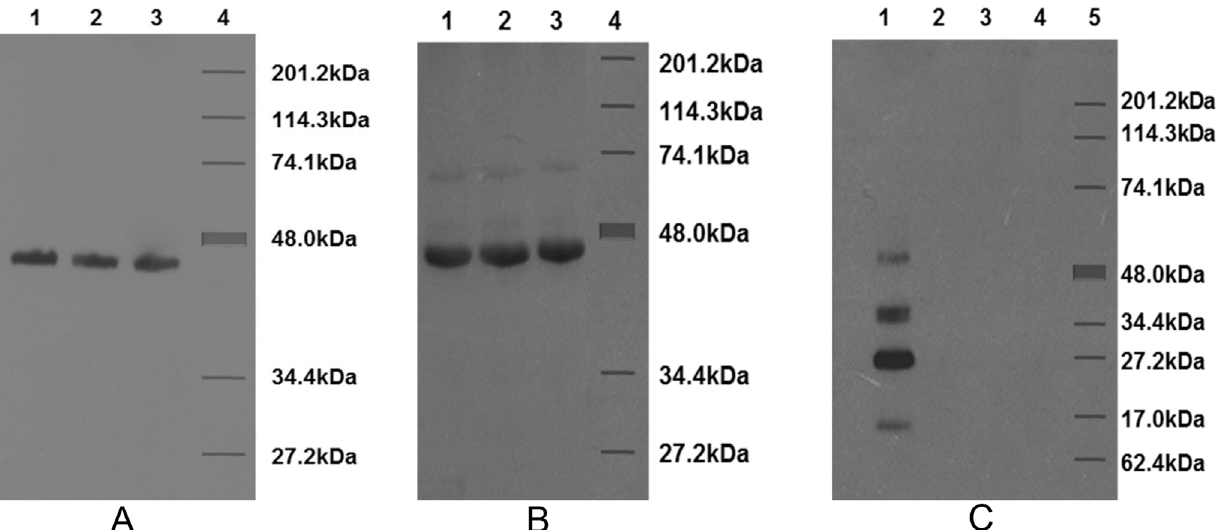
Fig 1. Western blots of enriched MOMPs from C . jejuni strains reacted with rabbit antiserum to the MOMP from C . jejuni strain 111 (A), with rabbit antibody to CT (Sigma) (B), and with rabbit antiserum to dmLT (C). SDS-12% PAGE-separated MOMPs were transferred to a nitrocellulose membrane and probed with the appropriate rabbit antiserum and then with anti-rabbit immunoglobulin. In panels A and B, lanes 1, 2 and 3 were loaded with MOMPs from C . jejuni 48, 75 and 111, respectively; lane 4 contains molecular weight markers. A prominent band of approximately 48 kDa corresponding to the MOMP is seen in all the three strains in panels A and B. The light band of approximately 74.1 kDa in panel B is a nonspecific band [9]. In panel C, lane 1 was loaded with dmLT, and 2 through 5, were the same as lanes 1 through 4 in panels A and B. There is a lack of reaction between the MOMPs and dmLT antibody in panel C. The different bands in lane 1 may represent different components of dmLT, namely B 5 , A, A1 and B 1 (from highest to lowest molecular weight).